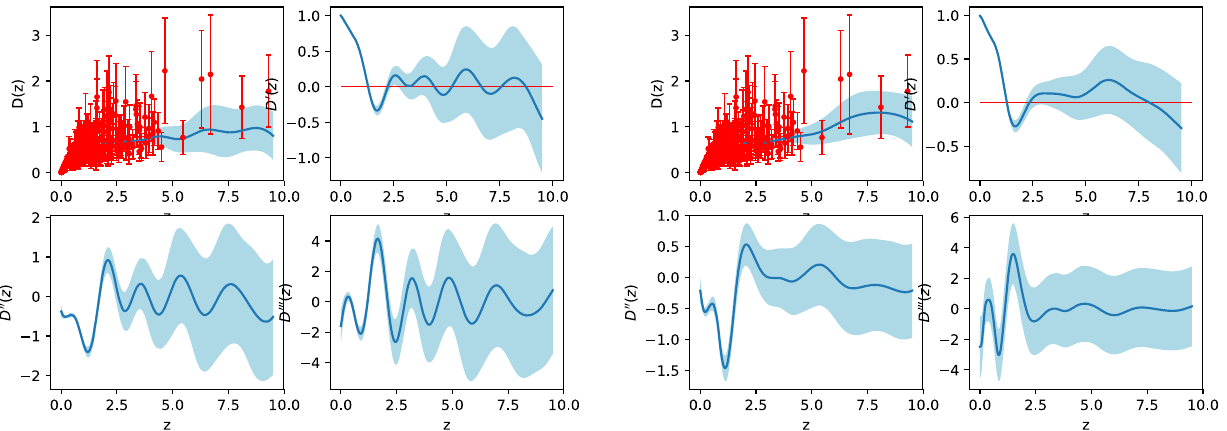
Fig. 3 Left panel: The reconstruction of D ( z ) and its derivatives as a function of redshift using Gaussian kernel by considering SNIa and GRBs. Right panel: The same plot using Matern ( ν = 7 / 2) kernel and the same data